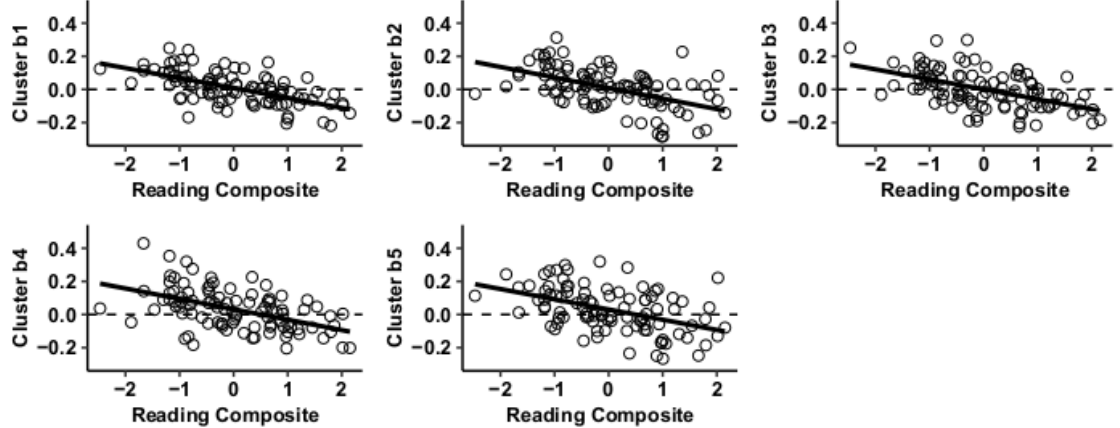
Figure 4. Whole-brain functional connectivity correlations with reading composite score for MVPA Cluster b.